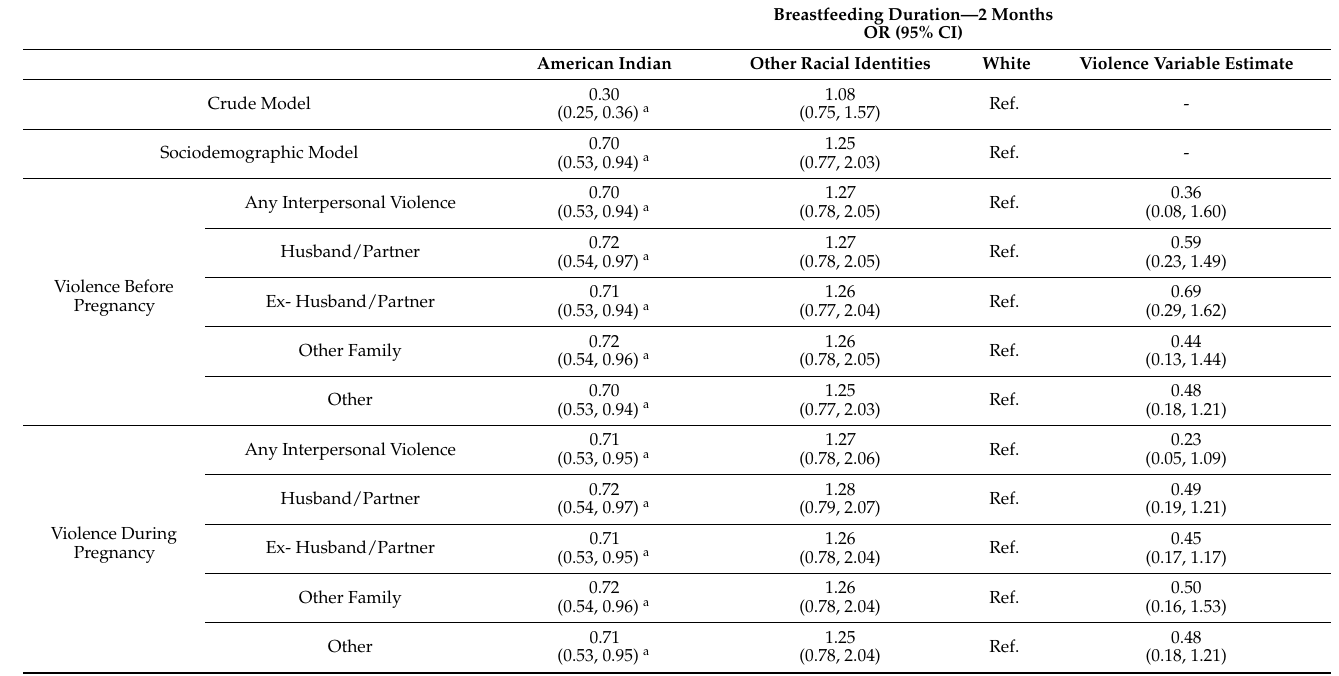
Table 4. Association between race/ethnicity and breastfeeding for at least two months, adjusted for violence exposure before and during pregnancy 1 .